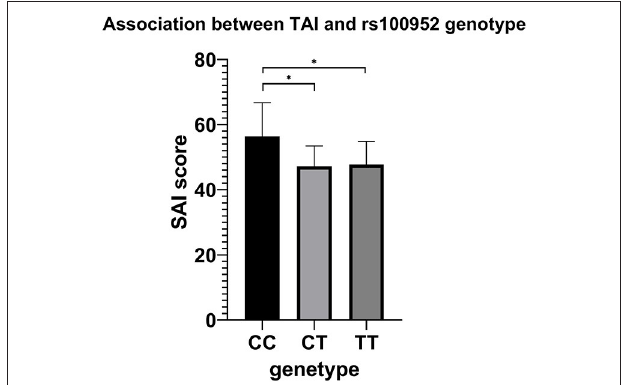
FIGURE 3 | Association results between TAI and rs100952 genotype, adjusted by sex and age of onset. The general linear model revealed a significant difference ( F = 3.744, p = 0.024). * p < 0.05 before FDR correction.